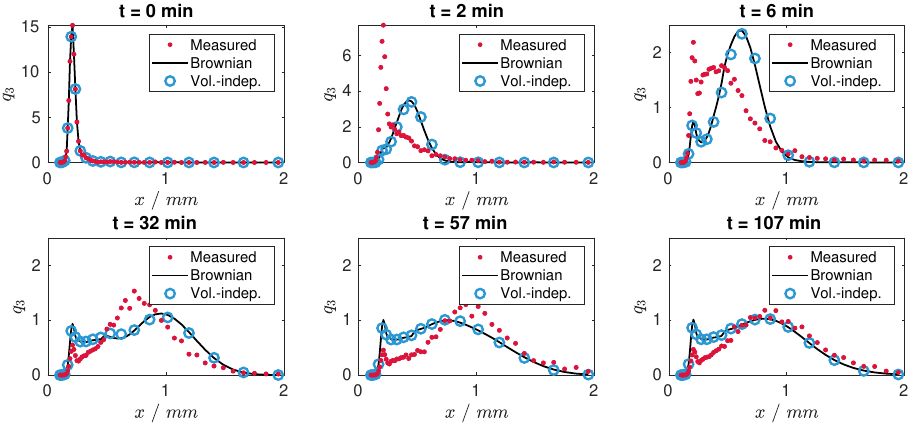
Figure 4. Snapshots of particle size distributions q 3 of the actual plant and identified